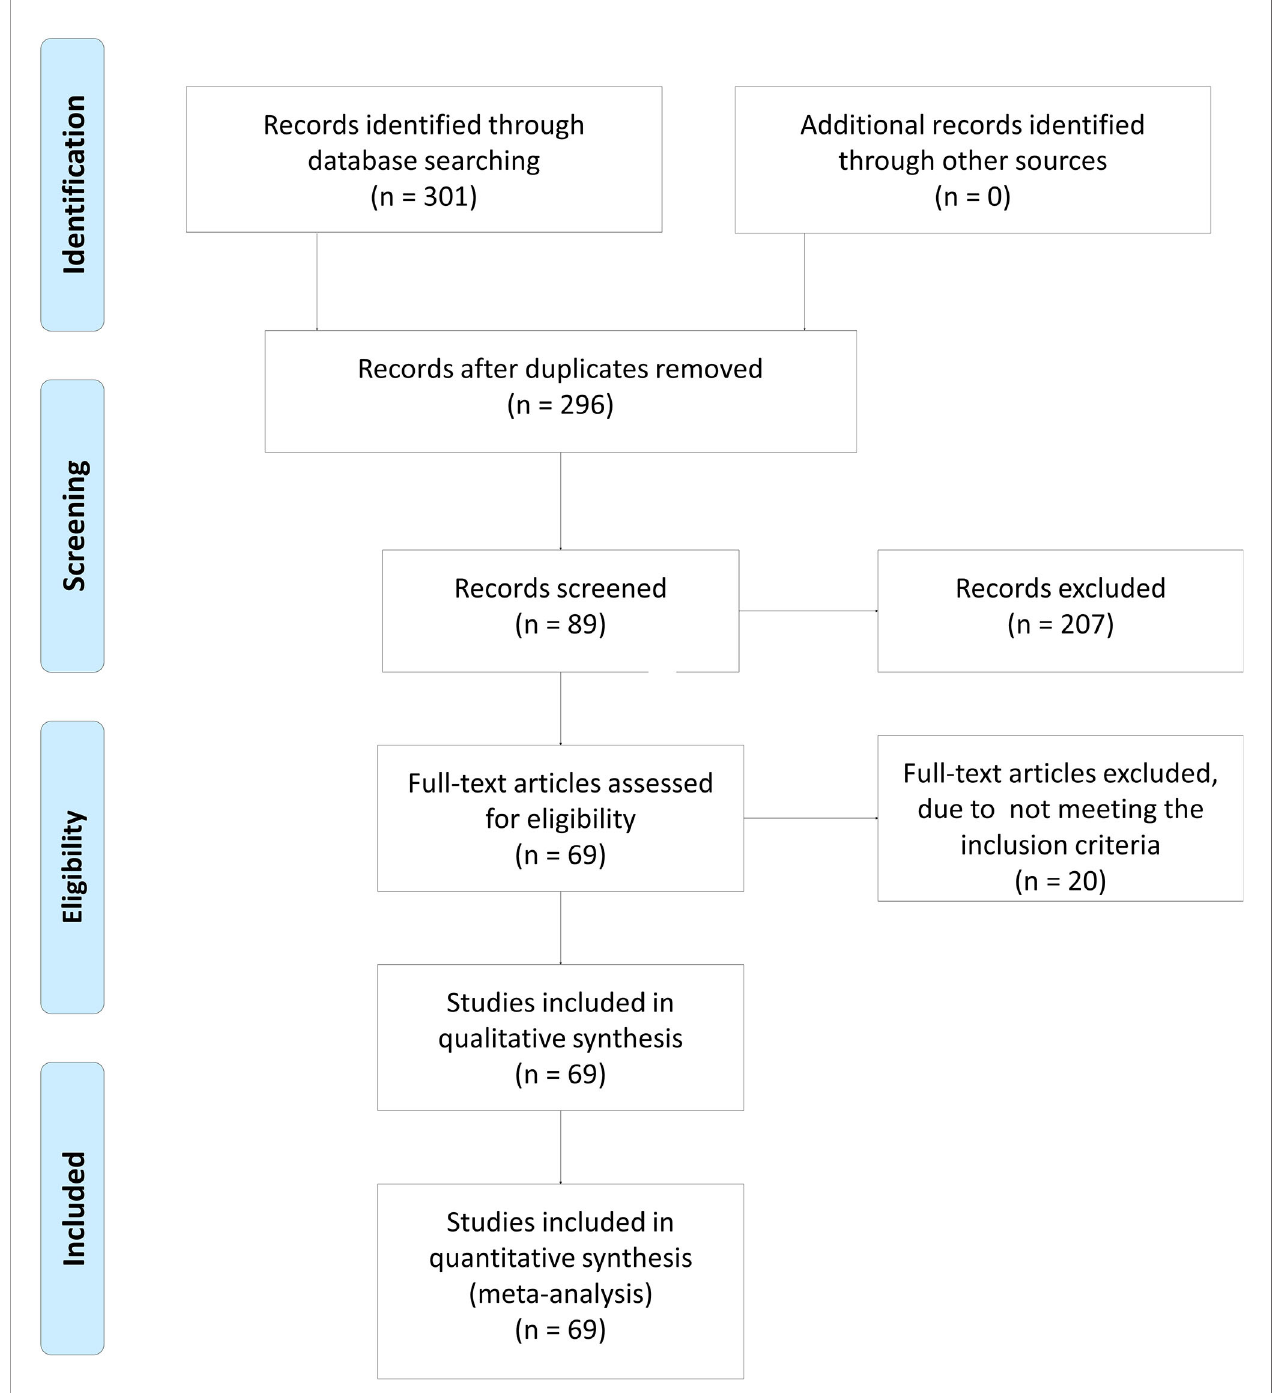
FIGURE 1 | The fl ow diagram of study inclusion. In total, 301 articles were identi fi ed using the searching strategy. Of these, 207 articles were excluded because they do not report the association. Then, fi ve articles were excluded due to duplication. Finally, 69 articles were included in meta-analysis. The fl ow diagram of study inclusion was cited from Moher et al.